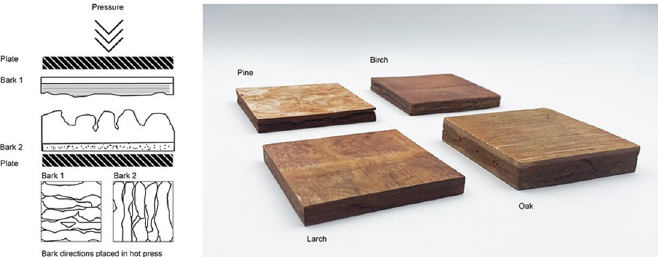
Fig 2. Arrangement of the bark pieces in the hot press (left). Produced panels with in-plane dimensions of 10 x 10 cm 2 and variable thicknesses determined by the natural structure of the pressed bark pieces (right).